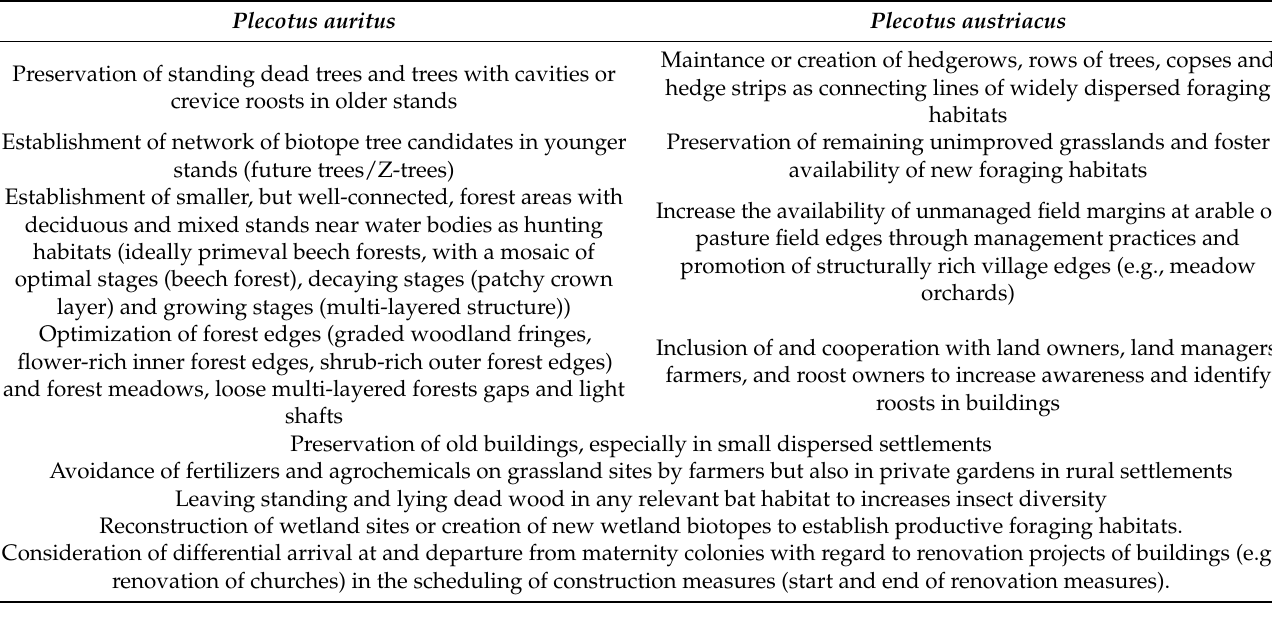
Table 2. Identified priority conservation needs for Plecotus auritus and Plecotus austriacus . Plecotus